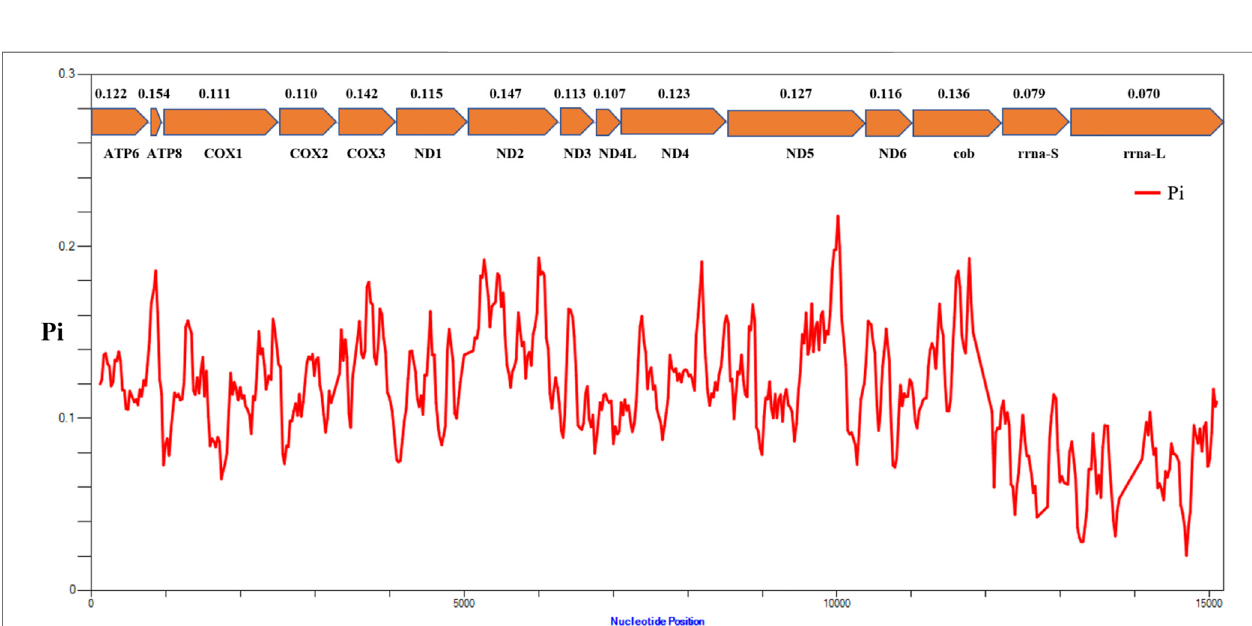
FIGURE 5 | Nucleotide diversity (Pi) of 13 PCGs and two rRNA genes between 16 families of the order Actiniaria. The red line shows the value of Pi in a sliding window analysis. The Pi value of each gene is shown under the gene name.